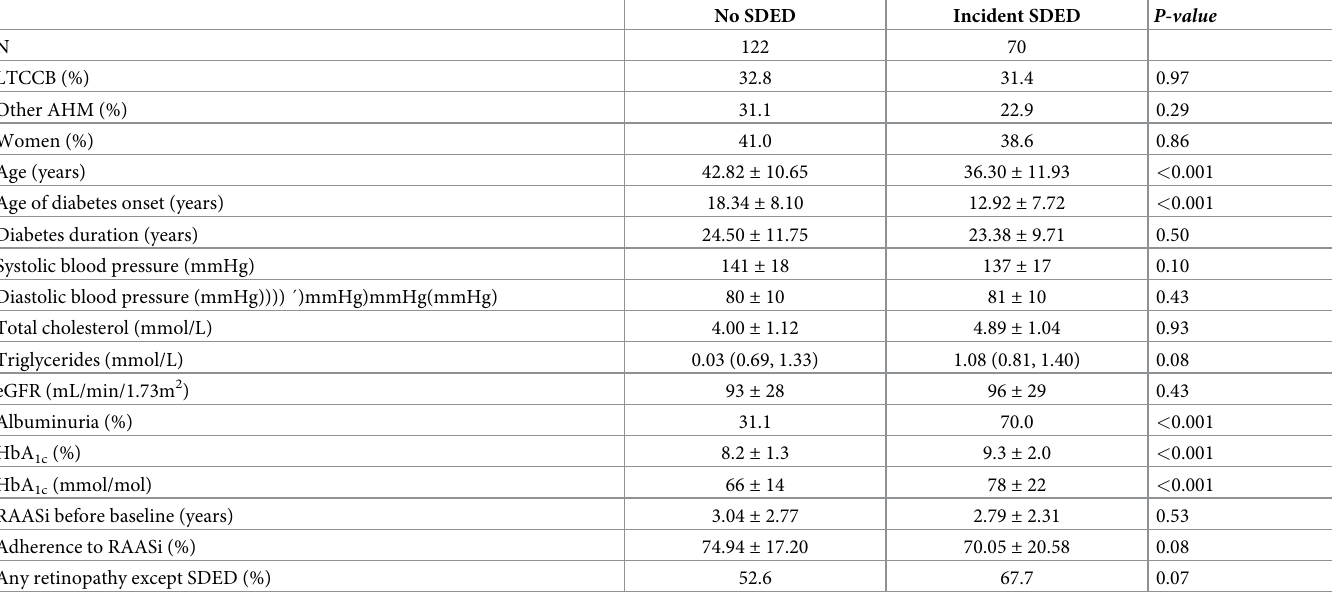
Table 1. Characteristics of individuals with type 1 diabetes participating in the observational study.